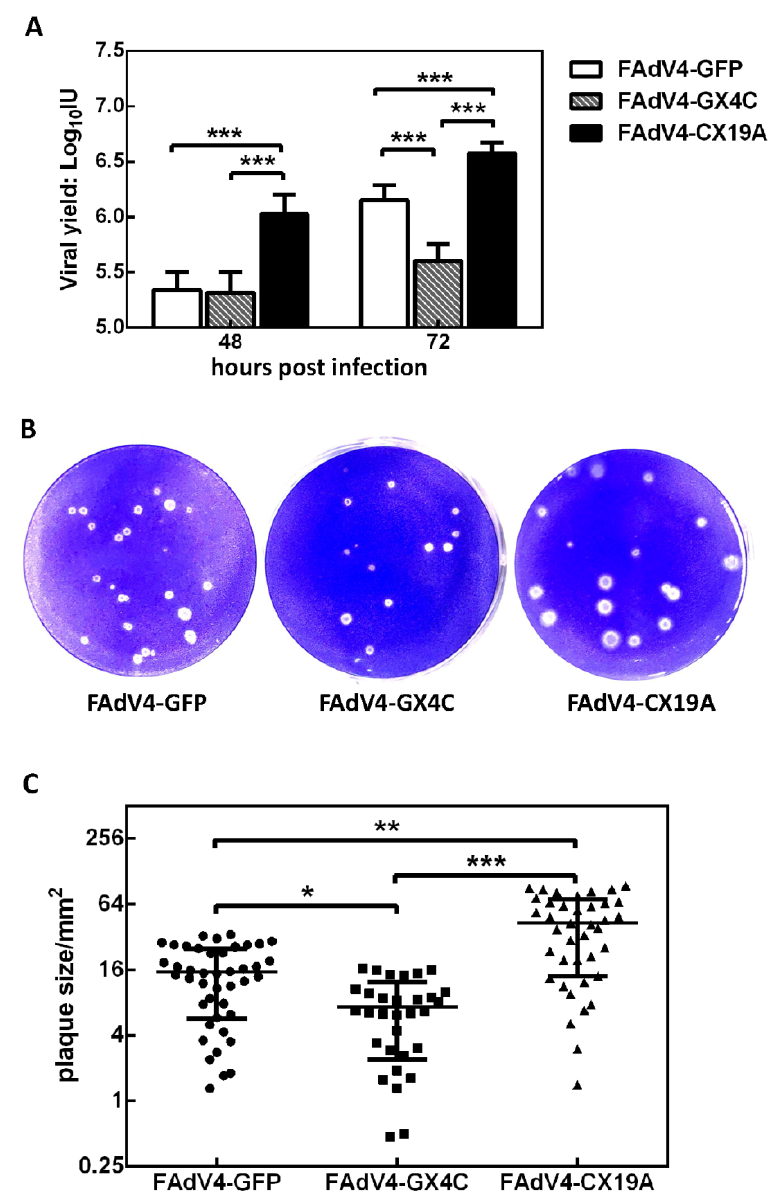
Figure 6. Viral replication in LMH cells. ( A ) LMH cells in 12-well plates were infected with FAdV4-GFP, FAdV4-GX4C or FAdV4-CX19A at a multiplicity of infection (MOI) of 50 vp / cell for 2 h. The progeny viruses were harvested 48 or 72 h after infection, and titrated on LMH cells. The viral yield (infectious units, IU) in one well was calculated and shown. ( B ) LMH cells in 6-well plates were infected with FAdV4-GFP, FAdV4-GX4C or FAdV4-CX19A at an amount of 8000 vp / well for 2 h. Cells were